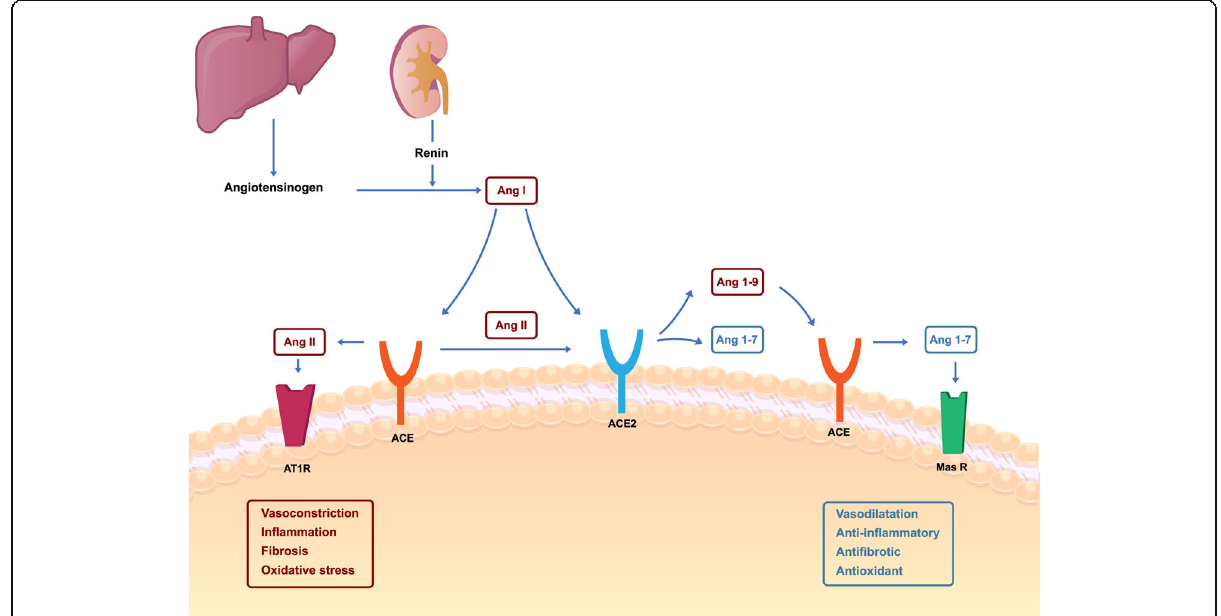
Fig. 1 Renin Aldosterone Angiotensin System in COVID-19. Angiotensinogen is produced by the liver and converted to angiotensin I by renin (produced by juxtaglomerular renal cells) in response to hypovolemia. Angiotensin I can be either converted by ACE into Angiotensin II or metabolized to Angiotensin 1 – 9 by ACE2. Moreover, angiotensin I can also be converted to Angiotensin 1 – 7 by ACE2. The Ang 1 – 7/MAS axis can have beneficial effects on lungs, while the Ang-II / AT1a axis have deleterious effects. Adapted from Yan, T, Xiao, R, Lin, G. 2020